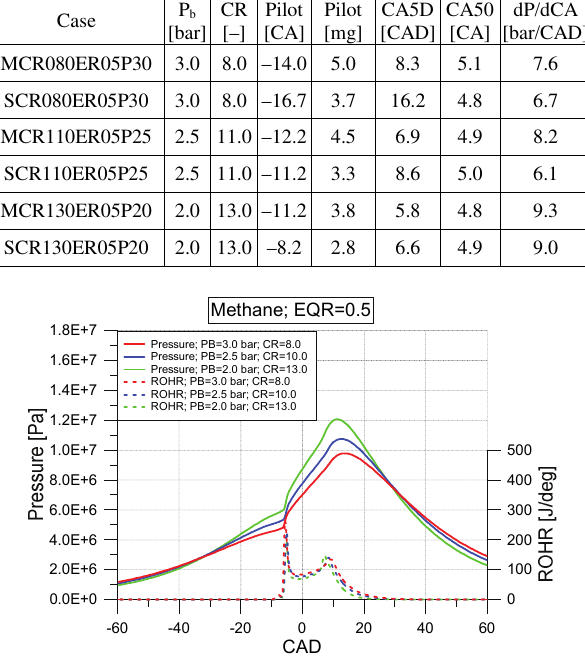
Fig. 8. Pressure trace and ROHR for methane and MPI mode